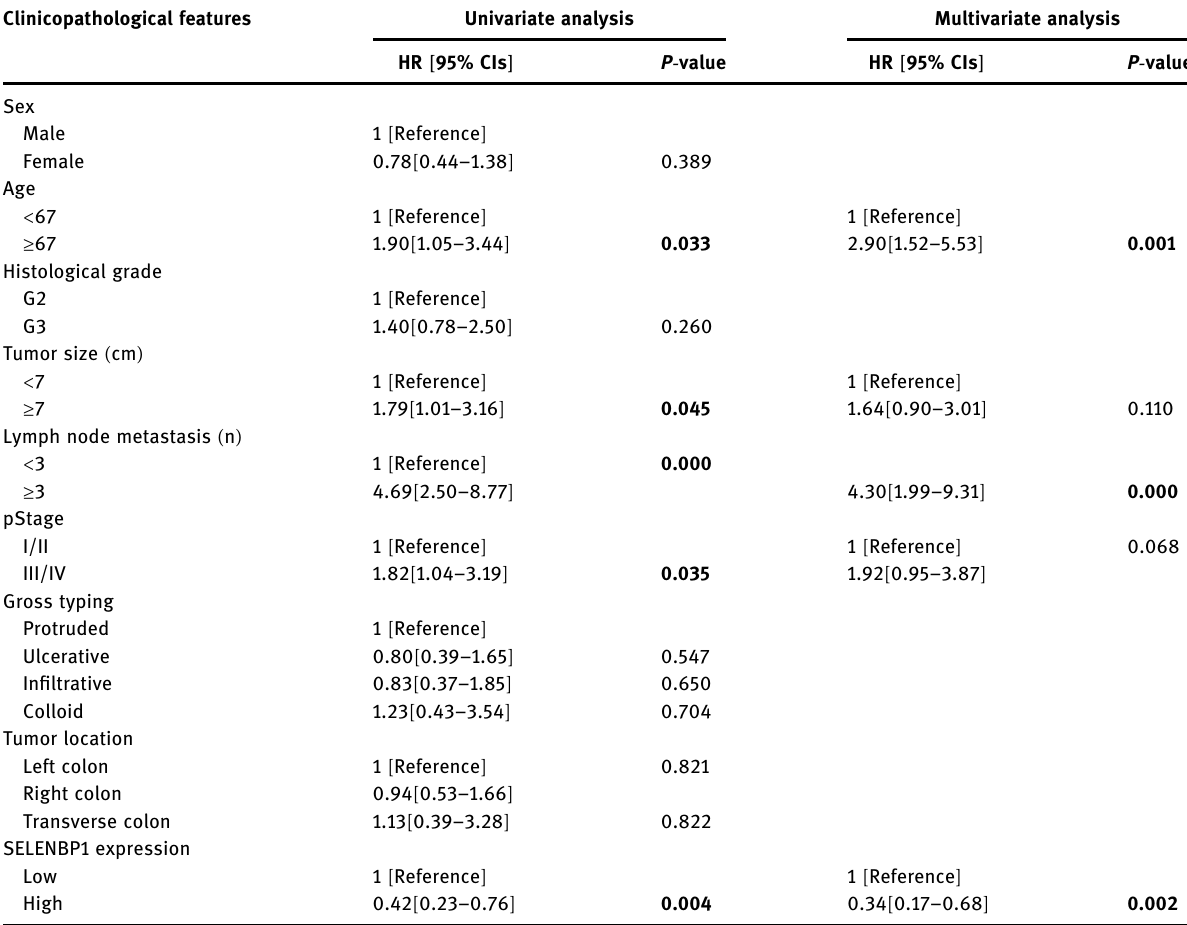
Clinicopathological